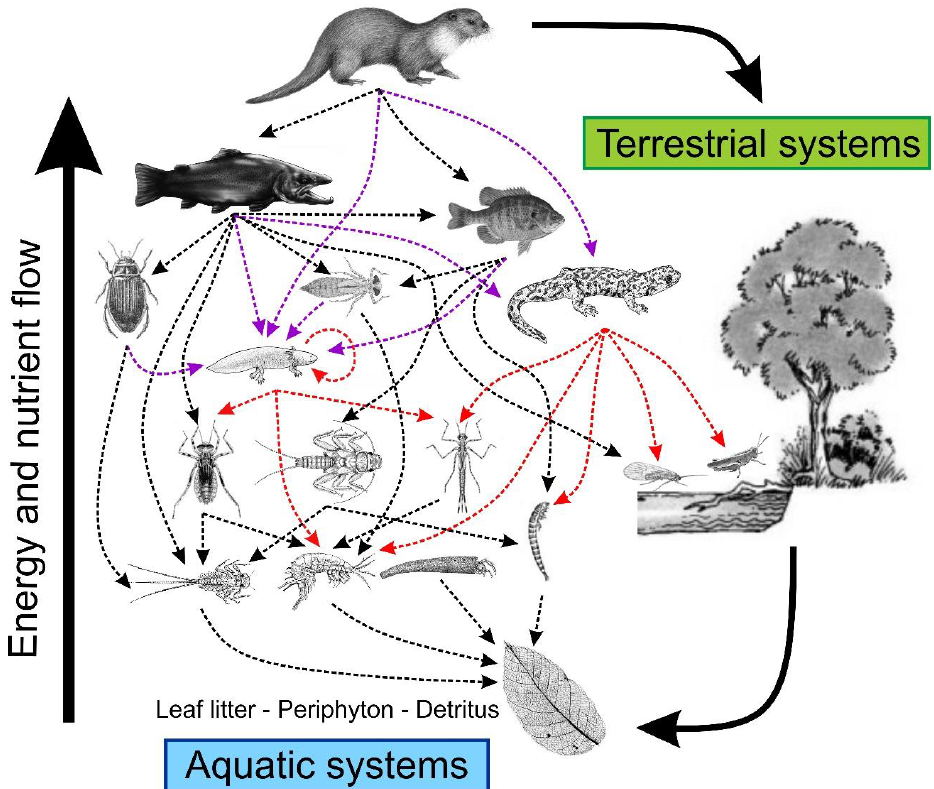
Figure 1. Conceptual view of a hypothetical aquatic food web dominated by semi-aquatic vertebrates (here Eurasian otter, Lutra lutra ), with salamanders as mid-level vertebrate predators and preys. Red dashed lines represent the interaction of salamanders as predators. Purple dashed lines represent the interaction of salamanders as prey. Arrows indicate the direction of predator–prey interaction and energy flow.